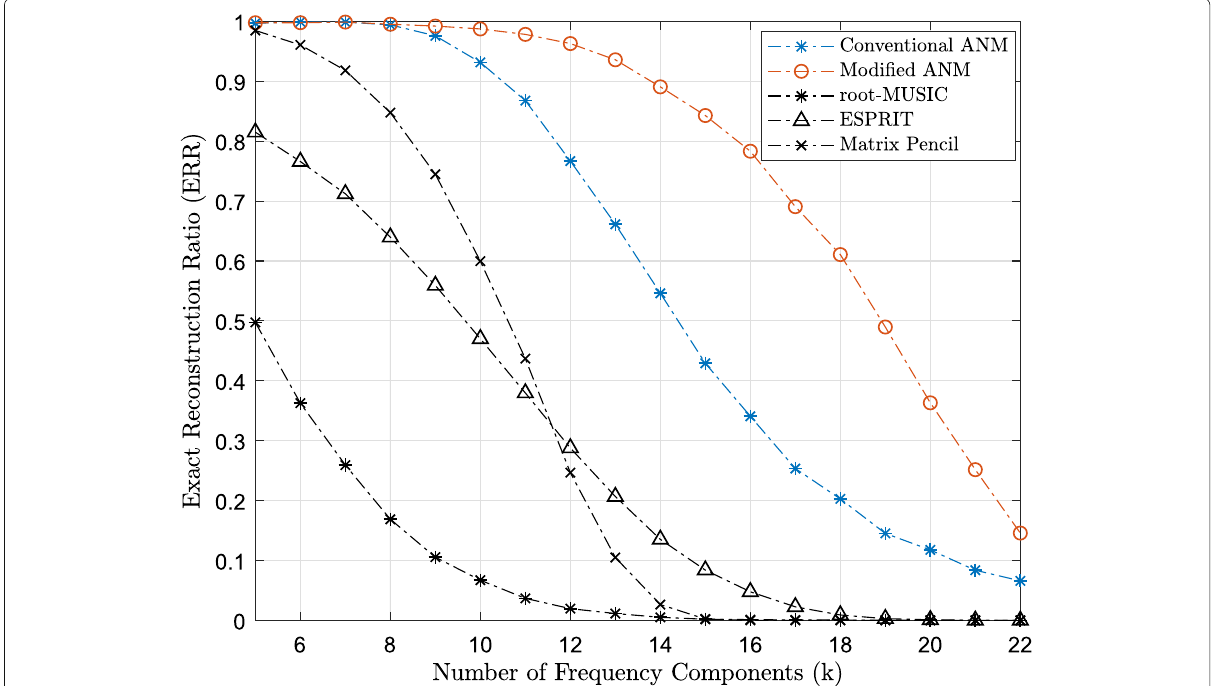
Fig. 4 ERR performance as a function of k